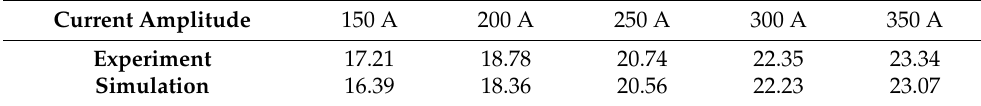
Table 4. Comparison of penetration ablation damage area between the experiment and simulation.